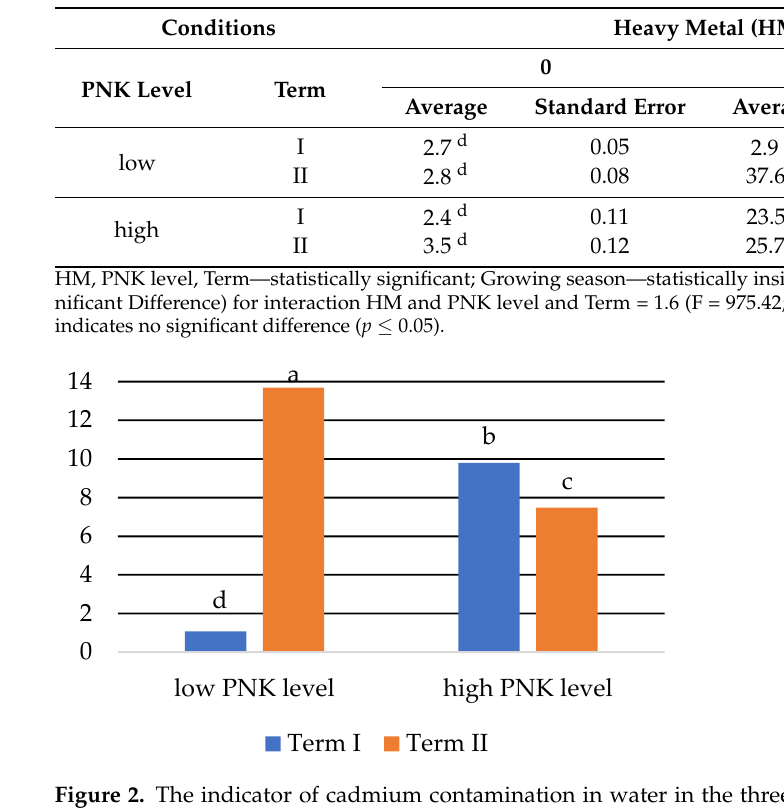
Figure 2. The indicator of cadmium contamination in water in the three tested growing seasons. Similar letter indicates no significant difference ( p ≤ 0.05).